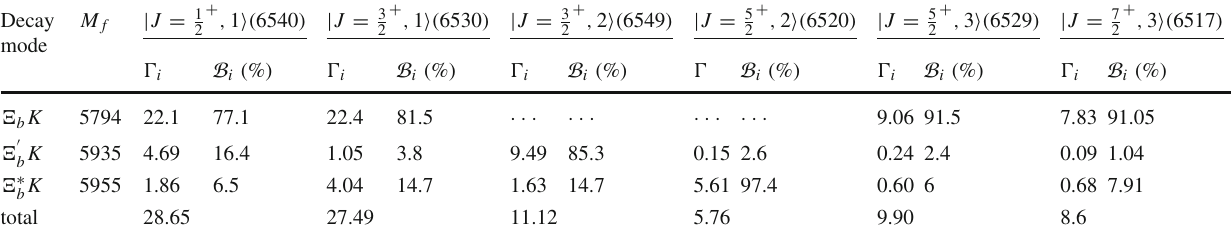
Table 6 Partial widths (MeV) of strong decays for the λ -mode D -wave (cid:2) b baryons, whose masses (MeV) are taken the quark model predictions of Ref. [13] M Decay mode